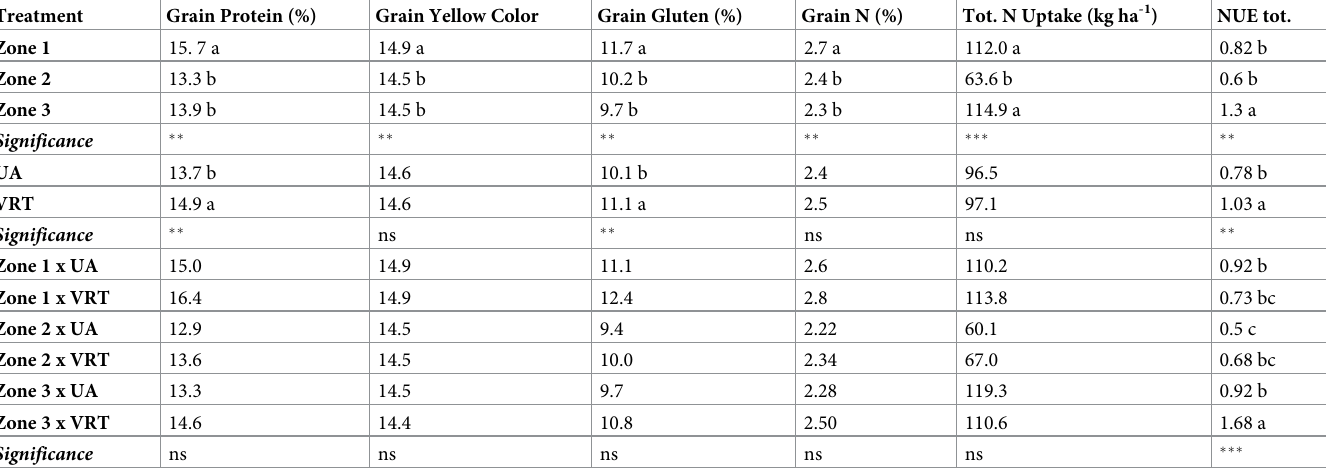
the sandy-loam area (zone 1) had highest grain quality. Overall nitrogen use efficiency was highest in zone 3, a clay loam area within the field. The low yield in area 2 may be ascribed to Table 4. Qualitative traits and nitrogen use efficiency of durum wheat.